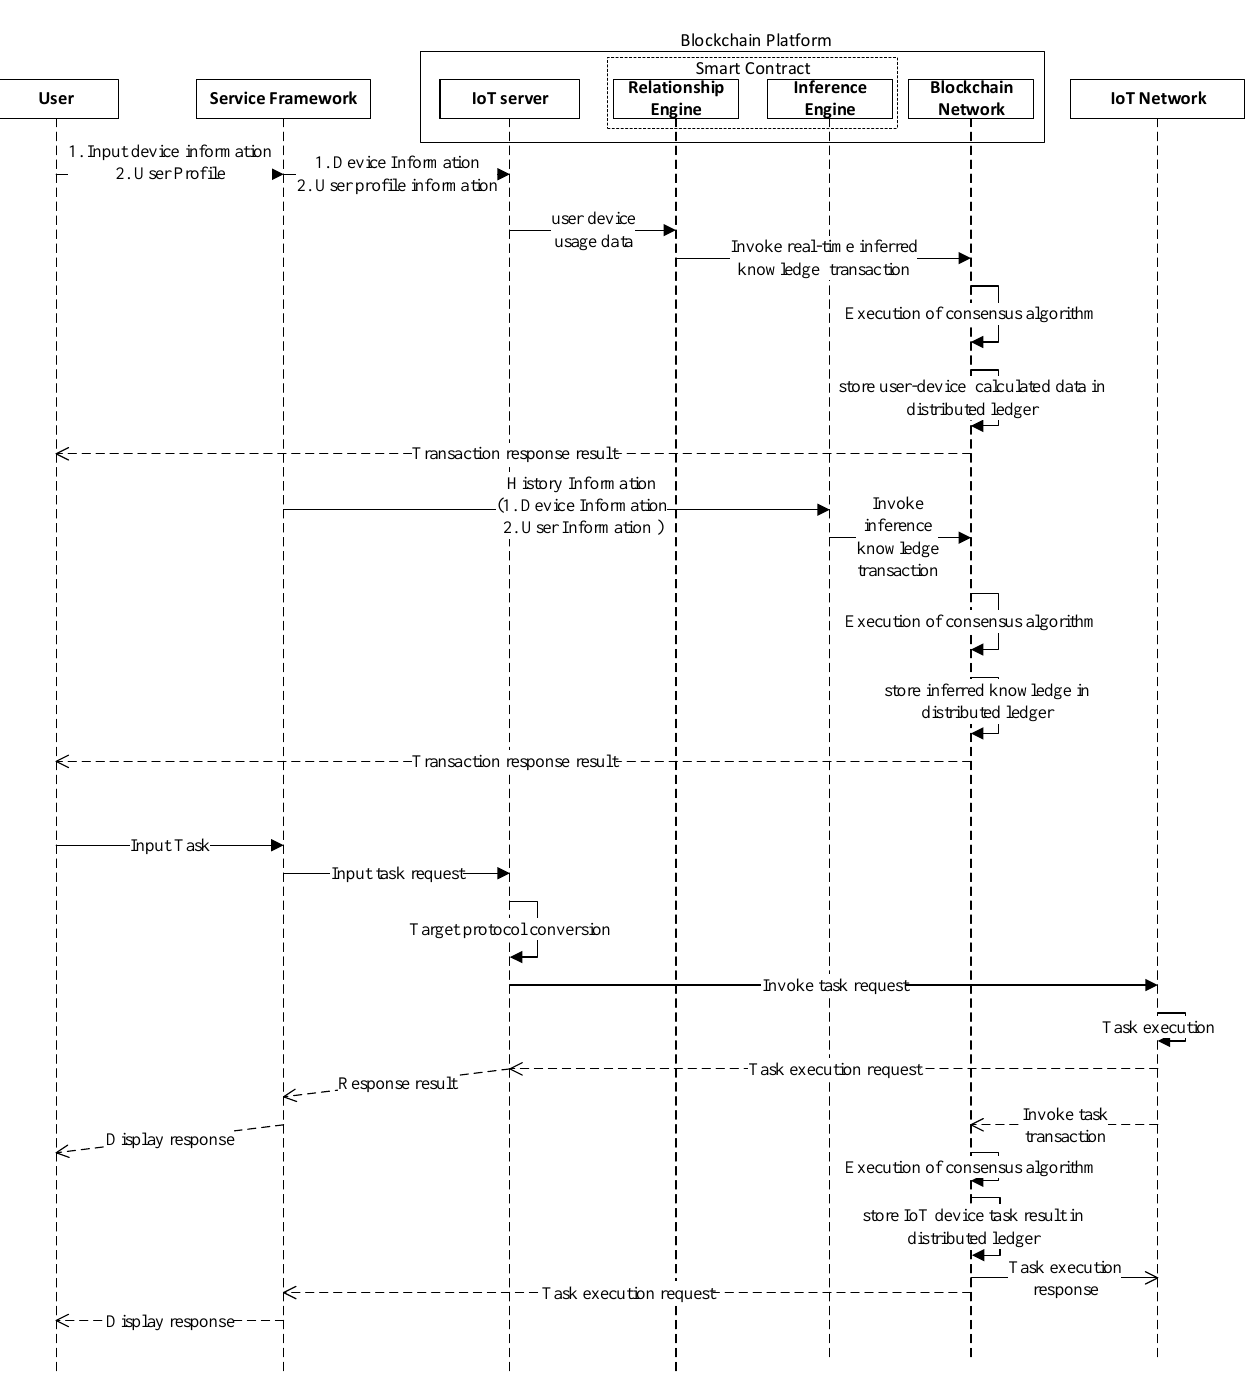
Figure 4. Sequence diagram of intelligent service based on enhanced smart contract enabled relationship and inference engine in IoT